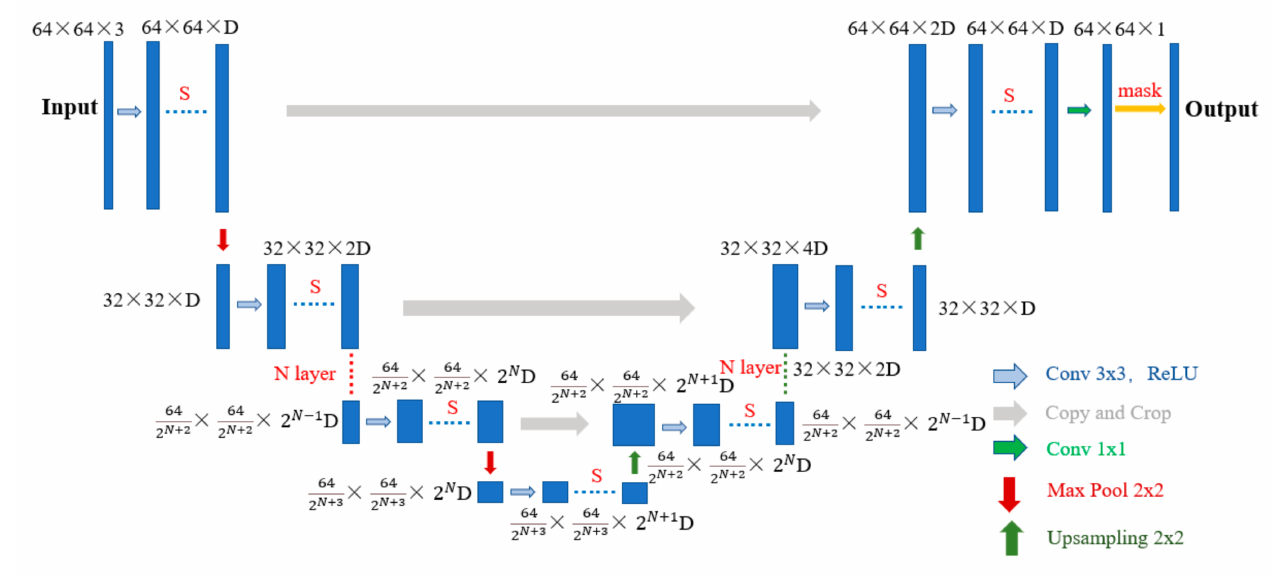
Figure 6. Modified UNet network